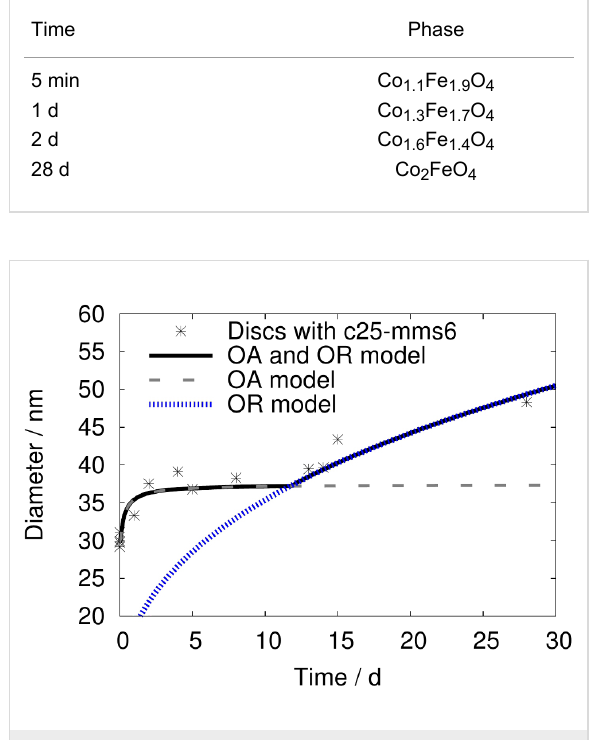
Figure 4: Change in the average disc diameter with time. The data is fitted with the kinetic model for an oriented attachment (OA) and Ostwald ripening (OR) process. The single contributions from the oriented attachment model as well as the Ostwald ripening are displayed as dashed